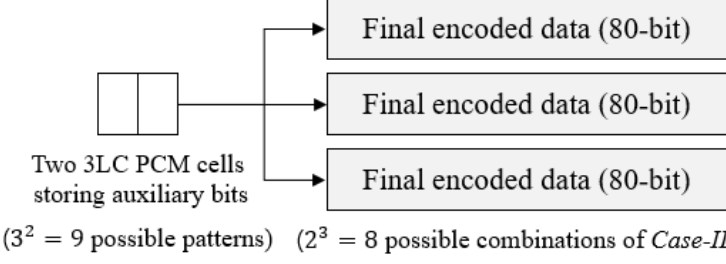
Figure 7. Example where three final encoded data share two auxiliary bits.